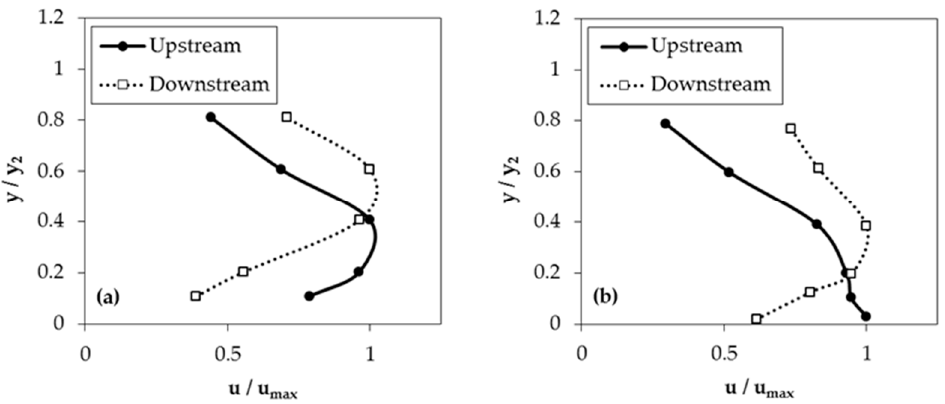
Figure 5. Vertical profiles of streamwise normalized velocity measured upstream and downstream the end sill of the USBR II stilling basin: ( a ) Physical model, ( b ) numerical model.